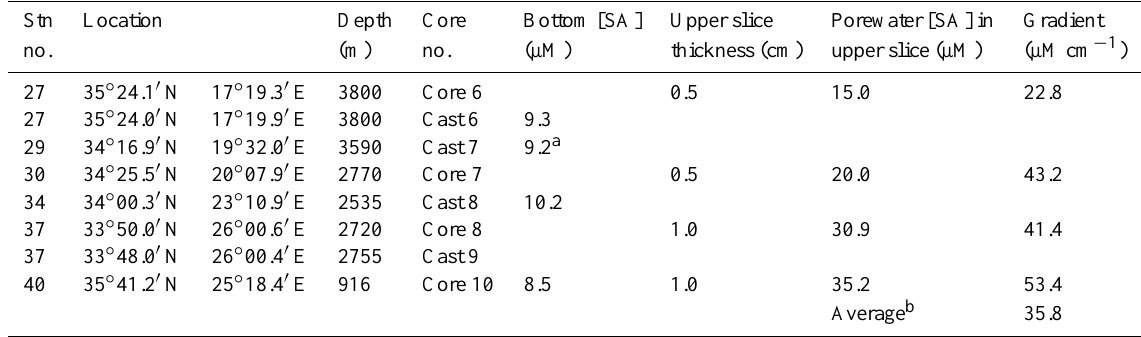
Table 1. Sampling stations, bottom silicic acid [SA] concentrations from hydrocasts in the water column of the deep EMS (Ionian and Levantine basins), and measurements from the upper layers of gravity cores used in calculations of diffusion gradients sampled during the TR-171 cruise of the R/V Trident in September 1975 (Jones, 1977). Stn Location Depth Core Bottom [SA] Upper slice Porewater [SA] in Gradient no. (m) no. (µM) thickness (cm) upper slice (µM) (µMcm − 1 ) 27 35 ◦ 24.1 0 N 17 ◦ 19.3 0 E 3800 Core